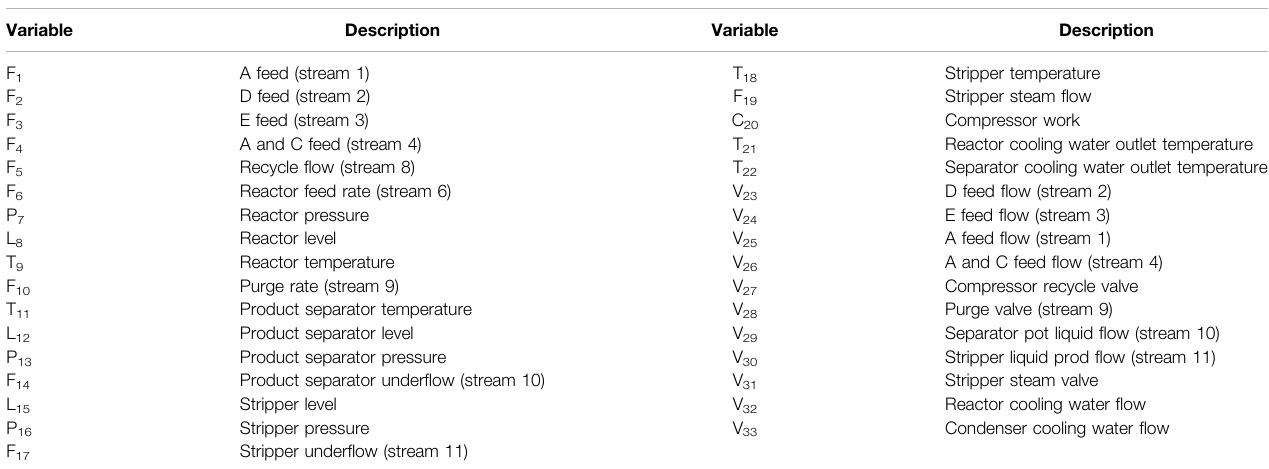
TABLE 1 | Variables in Tennessee Eastman